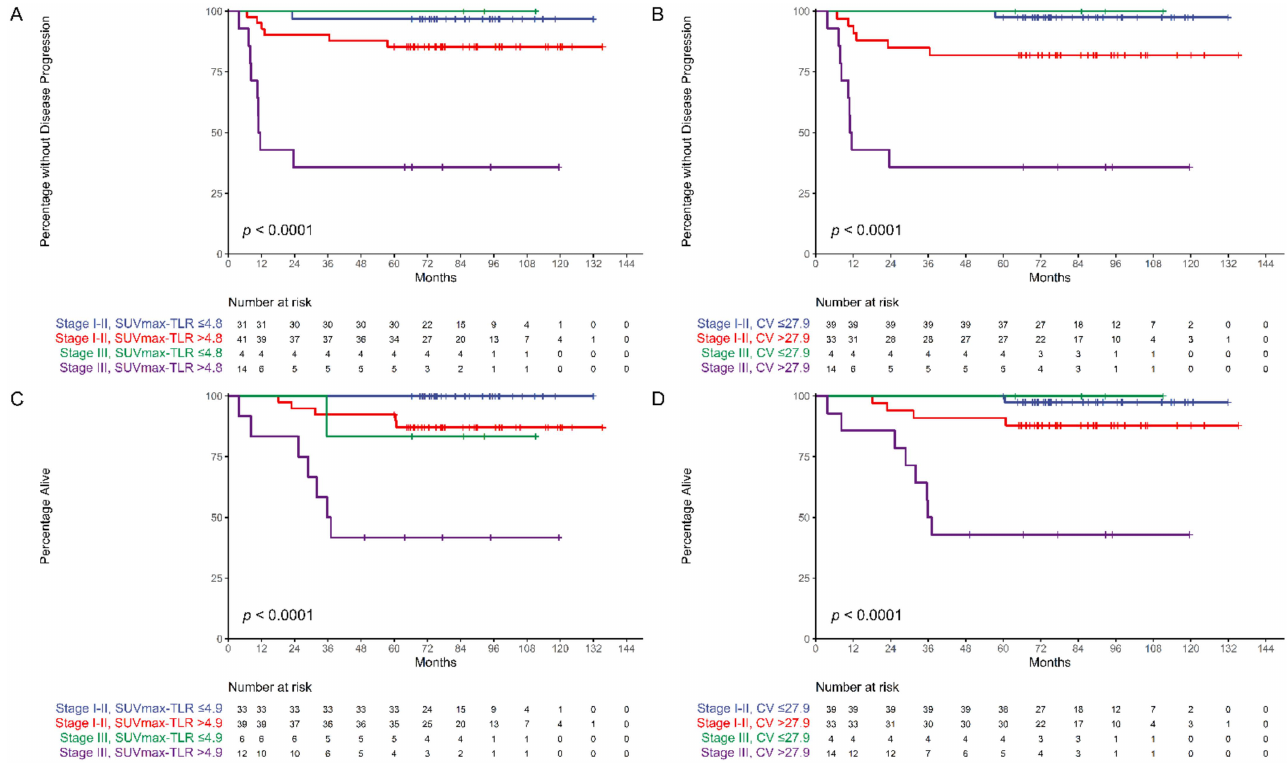
Figure 2. Kaplan–Meier estimates of progression-free survival ( A , B ) and overall survival ( C , D ) according to stage, and tumor SUV max to liver SUV mean ratio (SUV max -TLR) ( A , C ) or coefficient of variation (CV) ( B , D ). Global p values are presented to compare progression-free survival and overall survival across groups. Tick marks represent censored